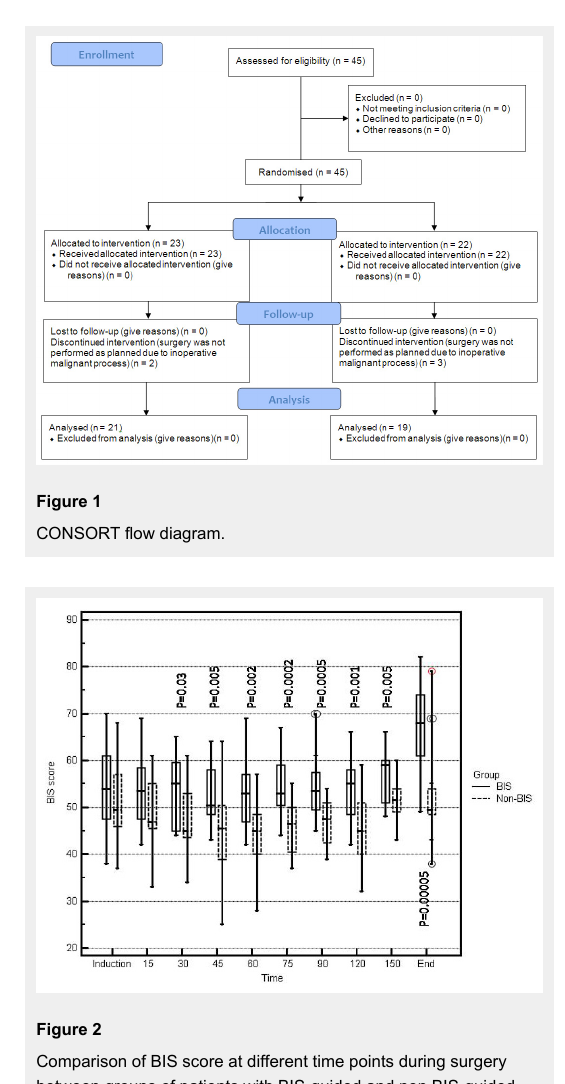
Comparison of BIS score at different time points during surgery between groups of patients with BIS-guided and non BIS-guided anaesthesia. Significant differences are marked and p values are